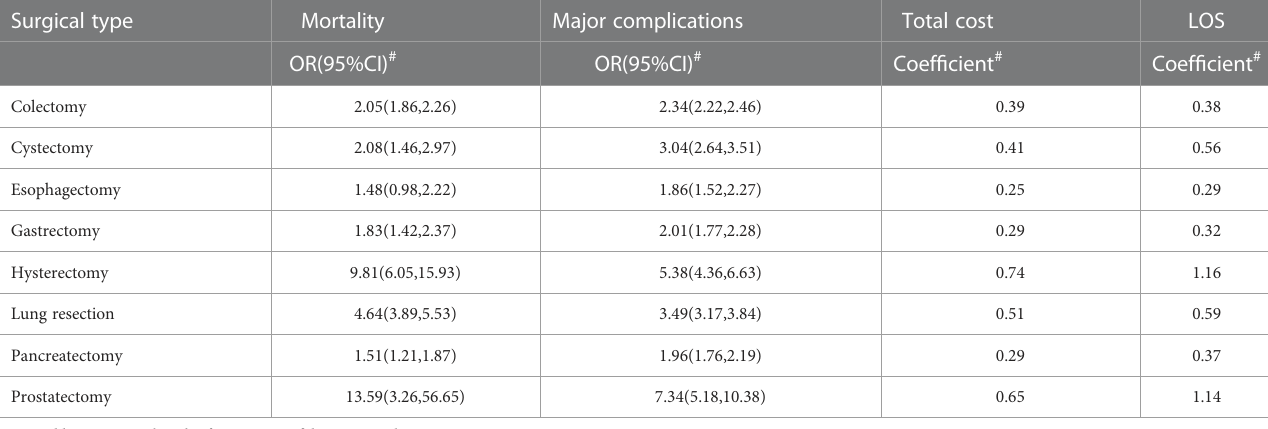
TABLE 3 Subgroup analysis according to cancer surgical